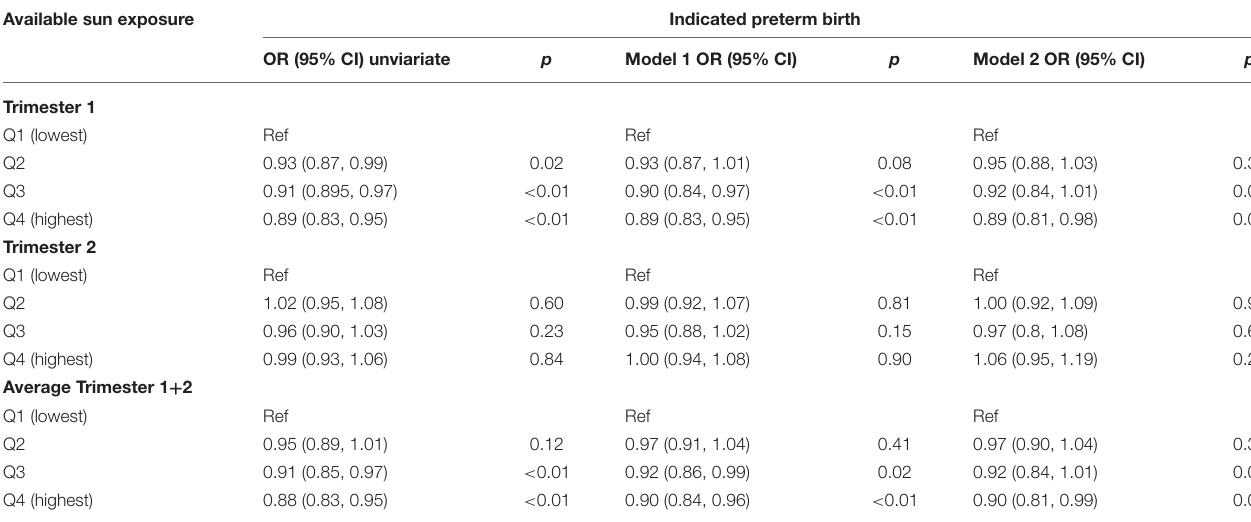
TABLE 5 | Association between mean sun hours per day available in trimester 1 and 2 and the combined average exposure over trimester 1 and 2 and indicated preterm births in Scotland 2000–2010. Available sun